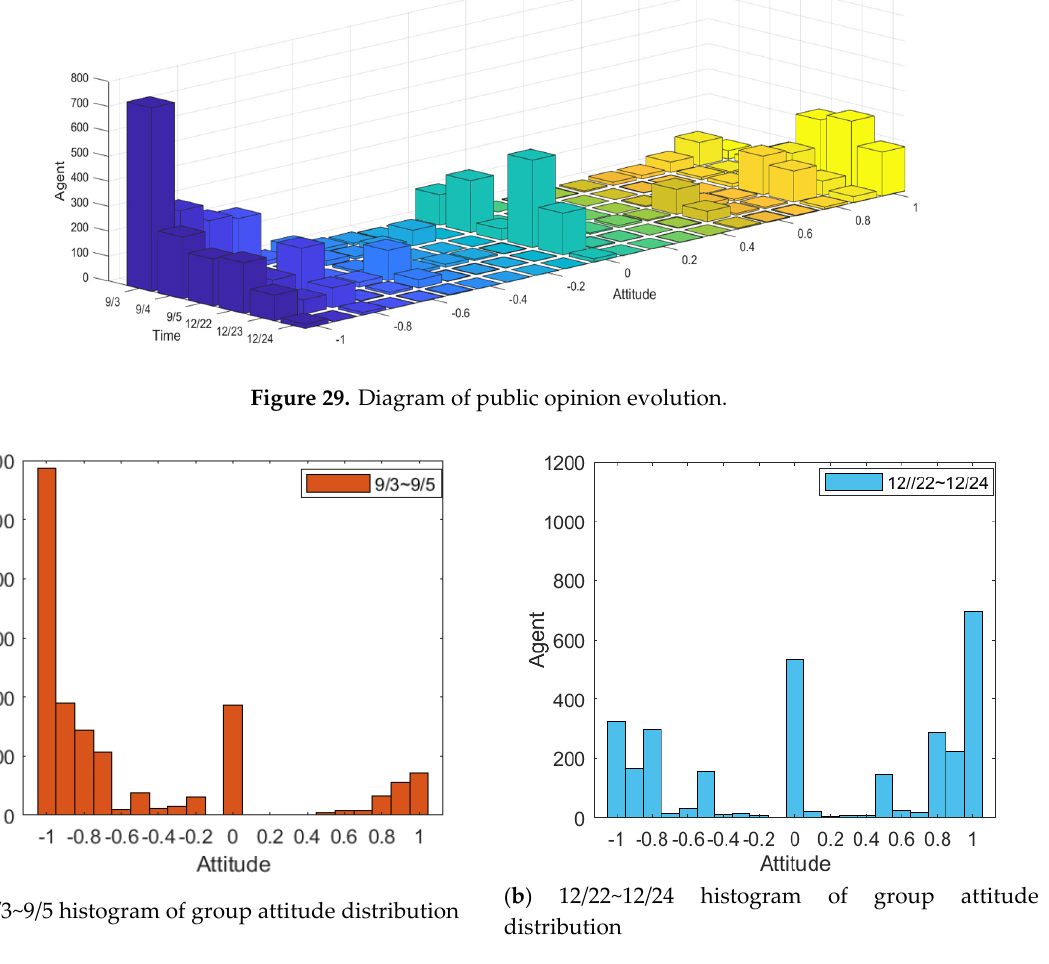
Figure 30. Histogram of group attitude distribution. ( a ) 9/3~9/5 histogram of group attitude distribution; ( b ) 12/22~12/24 histogram of group attitude distribution.